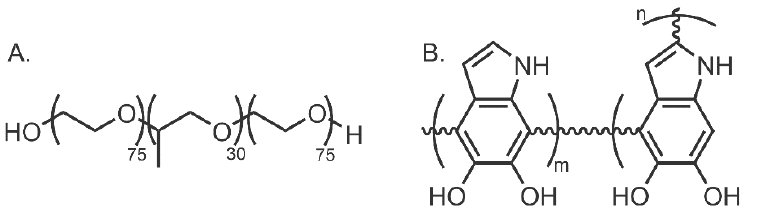
Figure 6. Structures of two polymer surfactants: ( A ) Pluronic F127 (synthetic); and ( B ) a proposed structure of polydopamine (natural).